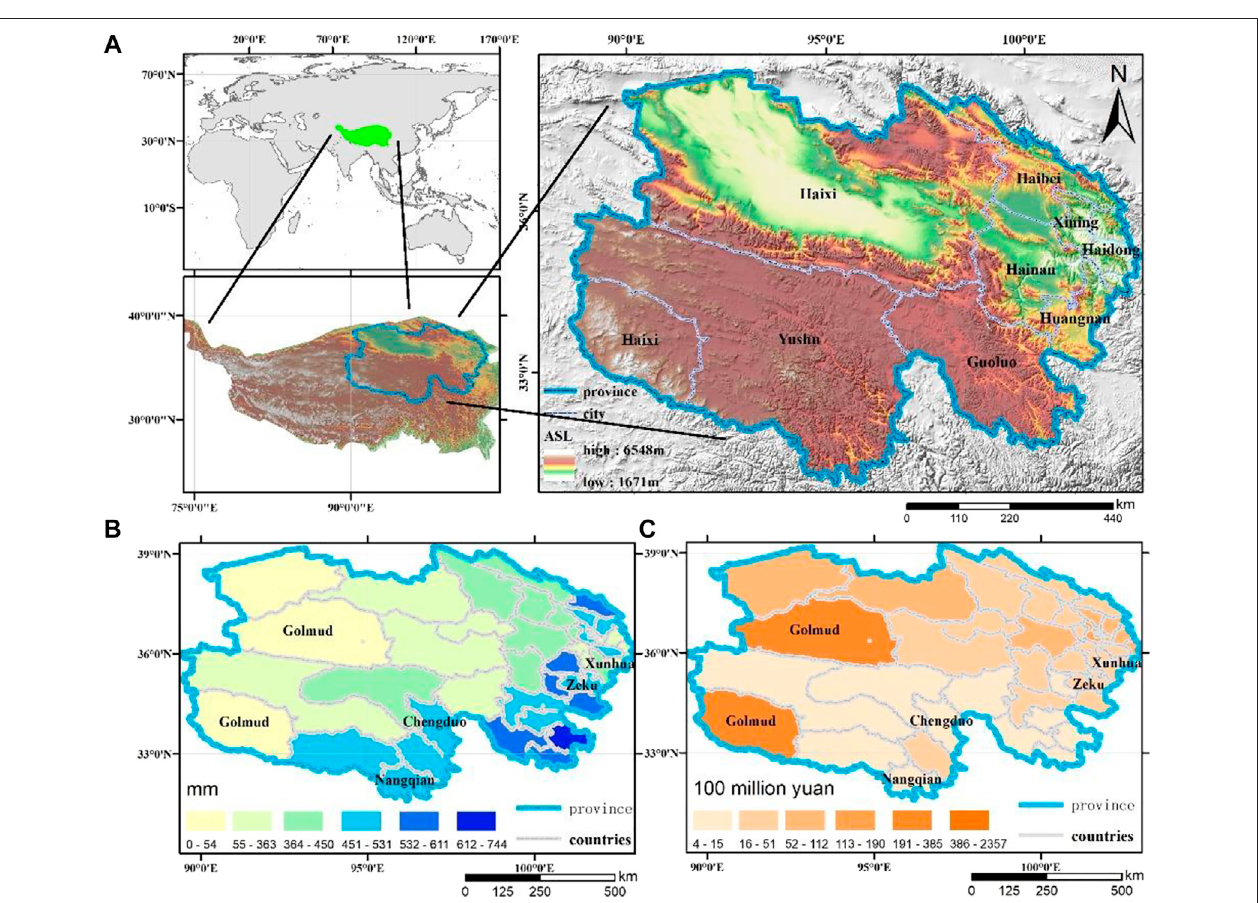
FIGURE 1 | Distribution landscape of natural and economic characteristics of Qinghai province. (A) Geographical location of Qinghai province and the Qinghai – Tibet Plateau, and the terrain of Qinghai province; (B) average precipitation distribution in Qinghai province from 2009 to 2019; (C) GDP distribution of Qinghai province in